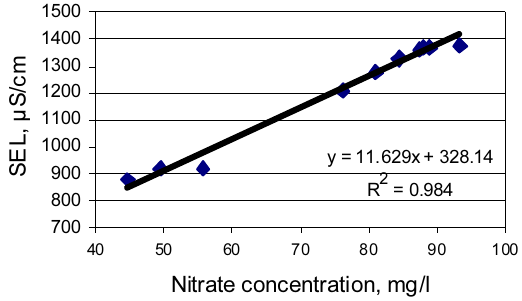
Fig. 1. Dependency of SEL on nitrate concentration